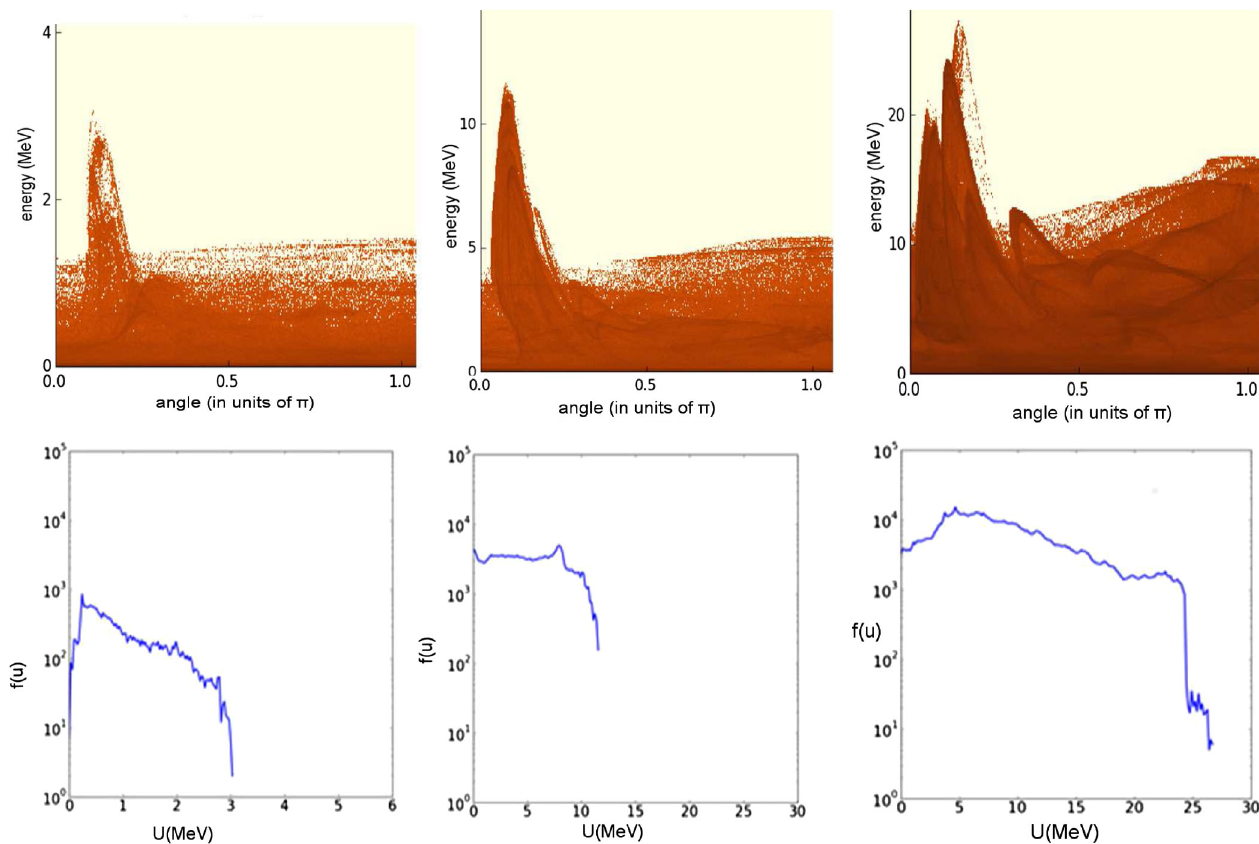
FIG. 8. Angular energy distributions (above) and single bunch energy spectra (below) at t ≈ 20 fs after the start of the interaction, for a 100 nm radius droplet hit by a laser pulse of intensities I ¼ 10 19 W = cm 2 , I ¼ 10 20 W = cm 2 , and I ¼ 10 21 W = cm 2